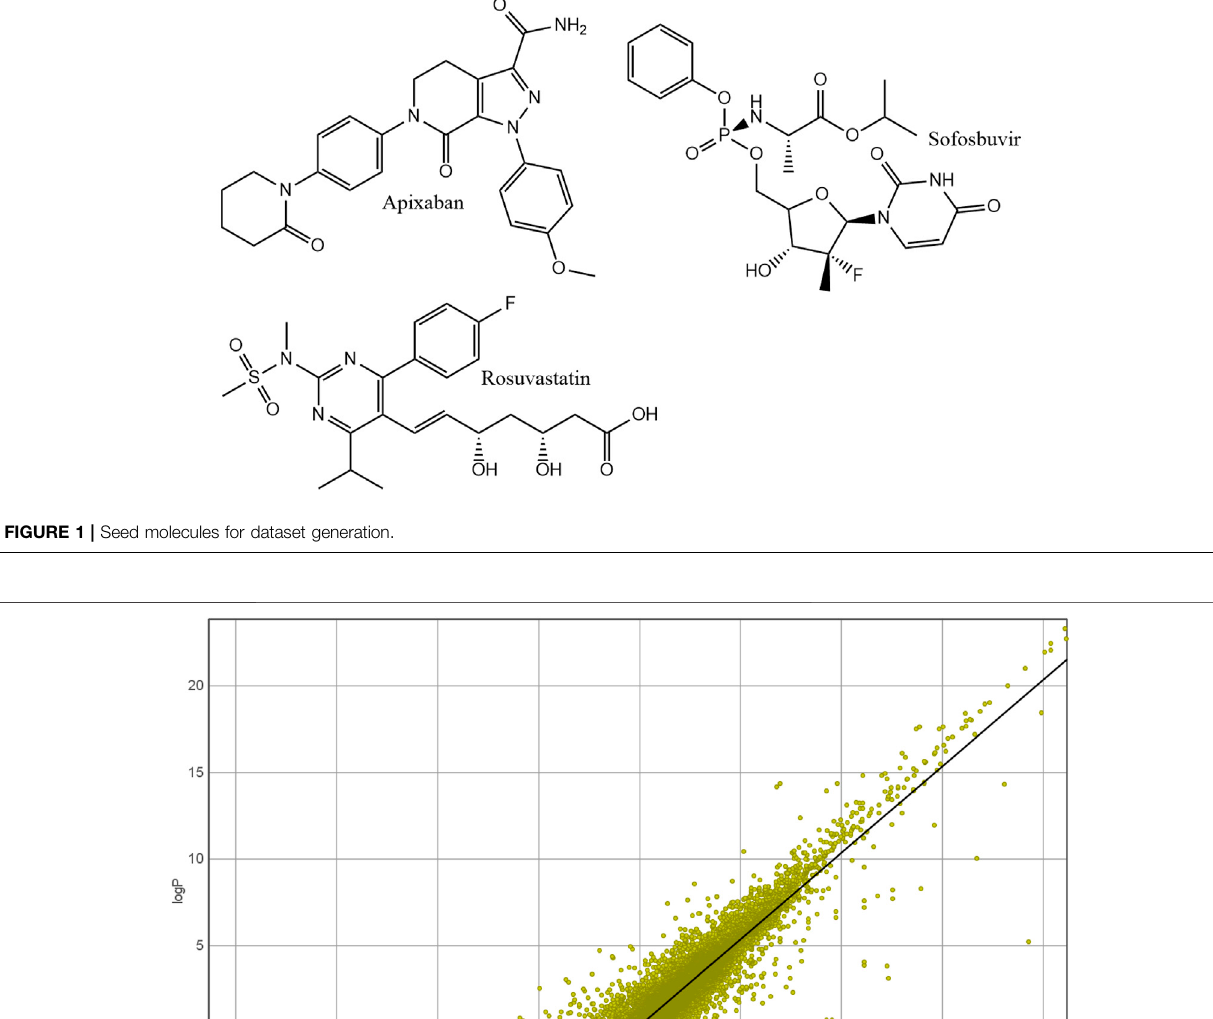
Figure 2 . The strong relation between the experimental and the calculated logP is shown by a correlation coef fi cient of 0.93.